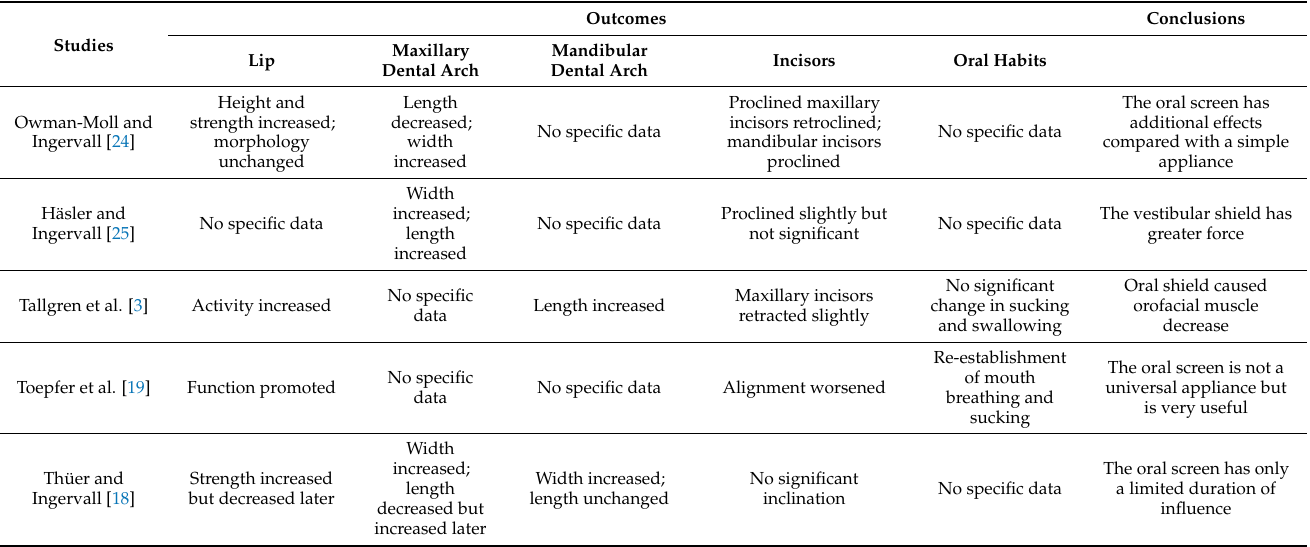
Table 3. Summary of outcomes of included